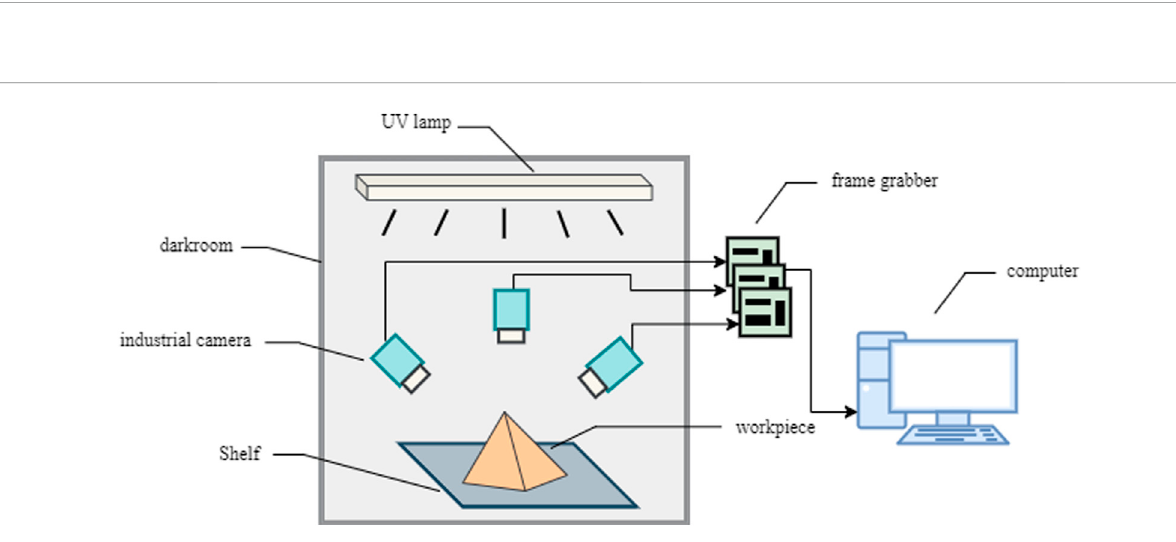
FIGURE 3 Fluorescence penetrant detection image acquisition platform.